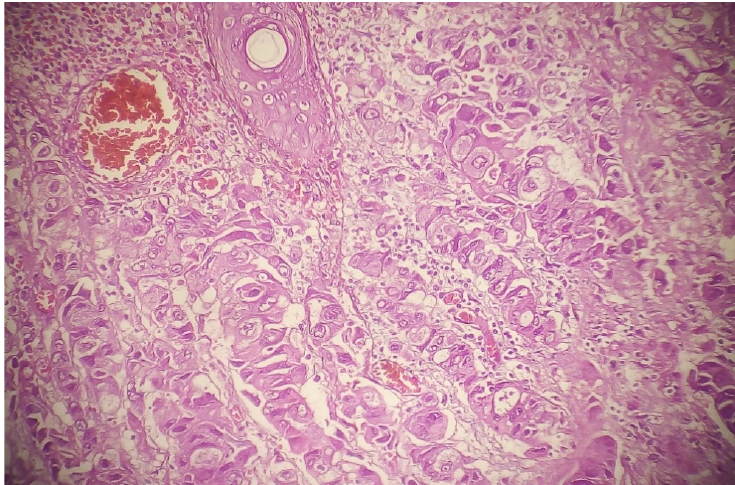
Figure 2. ASC of minor salivary gland.